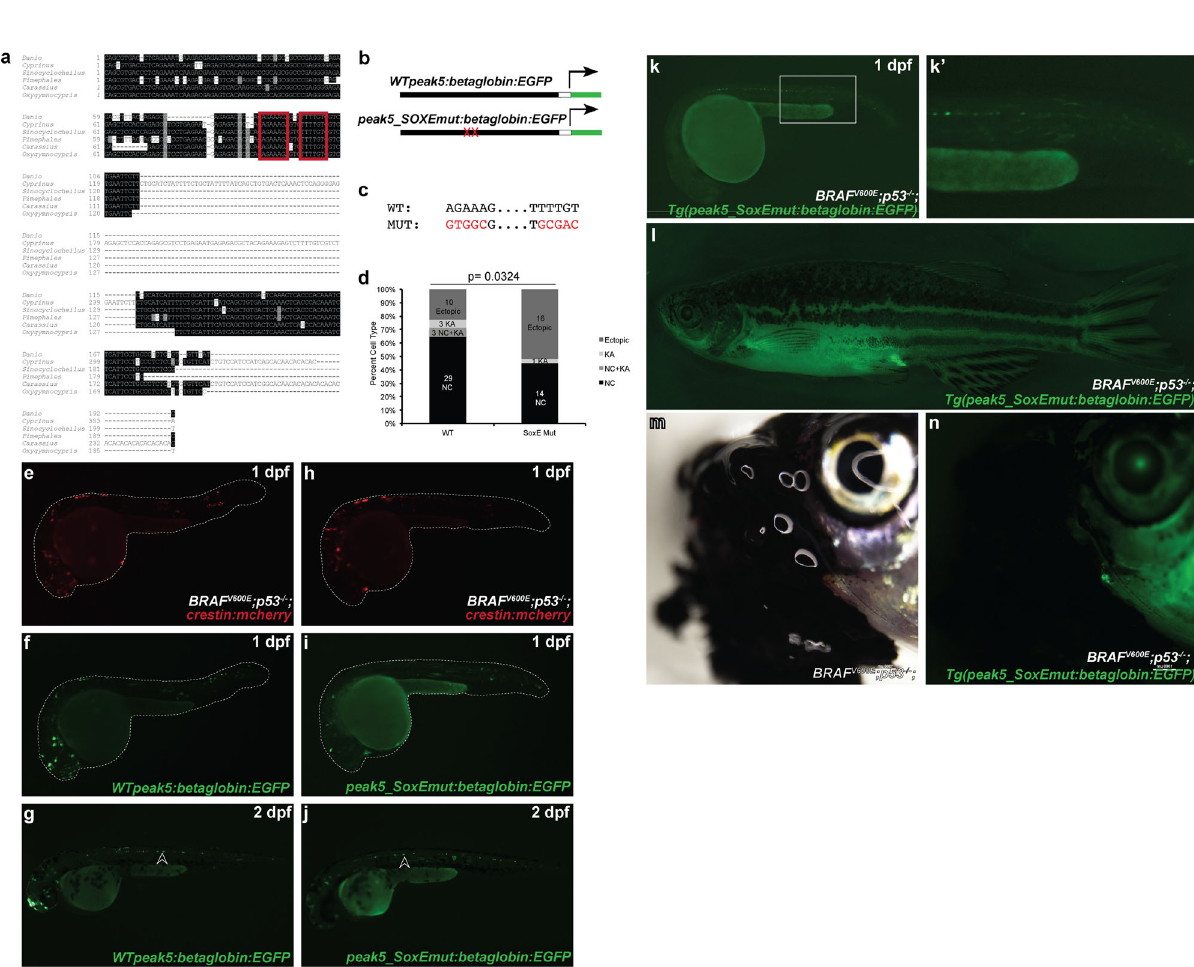
Fig. 5 Mutation of dimeric SoxE TFBS affect peak5 neural crest activity. a Dimeric SoxE TFBS, as predicted by JASPAR (outlined in red), are present in the conserved sequence of peak5 . b Schematic of plasmids used in the experiment. Mutations to SoxE TFBS were made in the context of the full-length WT peak5 plasmid. c Five out of six nucleotides for each motif were mutated. d Quanti fi cation of the percentage of categorizable EGFP + embryos exhibiting NC, KA, both NC, and KA, or ectopic expression in screened WT peak5 ( n = 45) and peak5_SoxEmut ( n = 31) injected embryos. NC neural crest, KA Kolmer – Agduhr neurons. p -value = 0.0324, Fisher ’ s exact test. Injection of crestin:mCherry simply served as a positive injection control in this experiment. e crestin:mch expression in an embryo injected with WT peak 5 and crestin:mch . f WT peak5 is strongly active in neural crest in F0 mosaics at 1 dpf. g WT peak5 is strongly active in neural crest-derived cells and KA neurons at 2 dpf. h crestin:mch expression in an embryo injected with peak5_SoxEmut and crestin: mch . i peak5_SoxEmut is not active in the neural crest in F0 mosaics, but j is active in KA neurons. Arrowheads indicate KA neurons. k – k ′ Stable transgenic peak5_SoxEmut lines exhibit peak5 activity in KA neurons, but do not exhibit labeling in posterior premigratory neural crest cells. l Adult stable transgenic lines do not exhibit peak5 activity in barbel peripheral nerves. m , n Tumors that develop in Tg(peak5_SoxEmut:EGFP) lines are EGFP